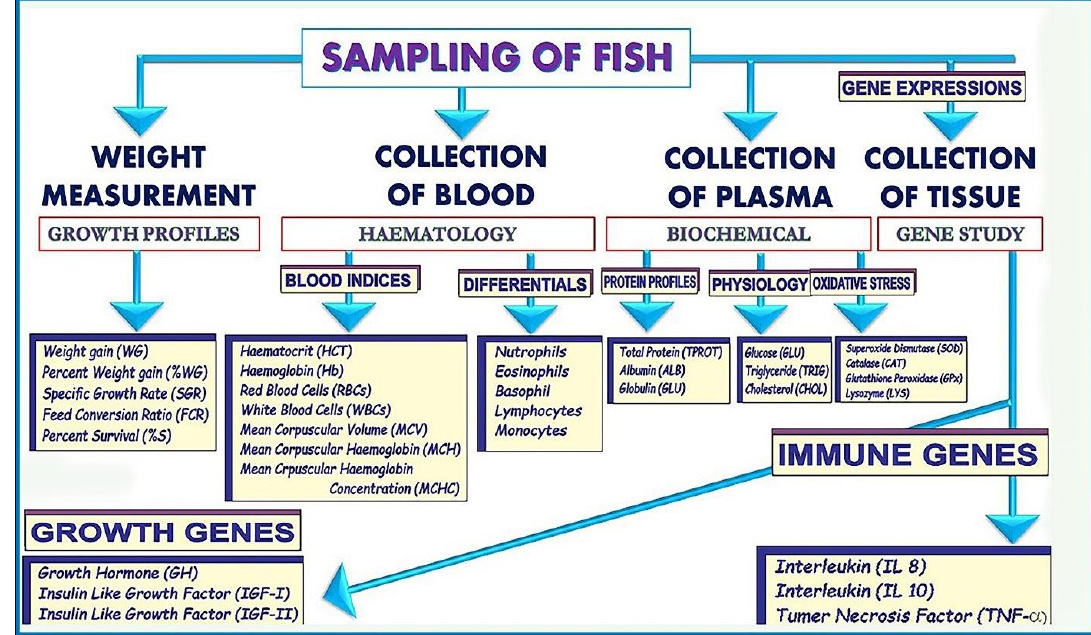
Figure 3. Flow chart representing the stepwise methodology during the 90 days of feeding trials with lapsi fruits Hematological